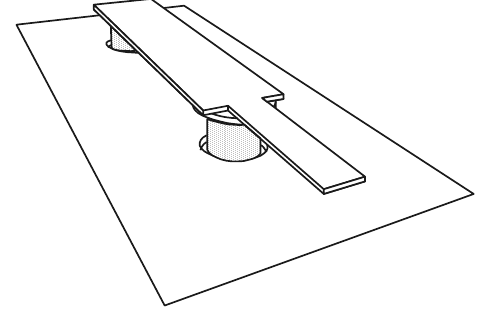
Figure 1. The model of construction part of